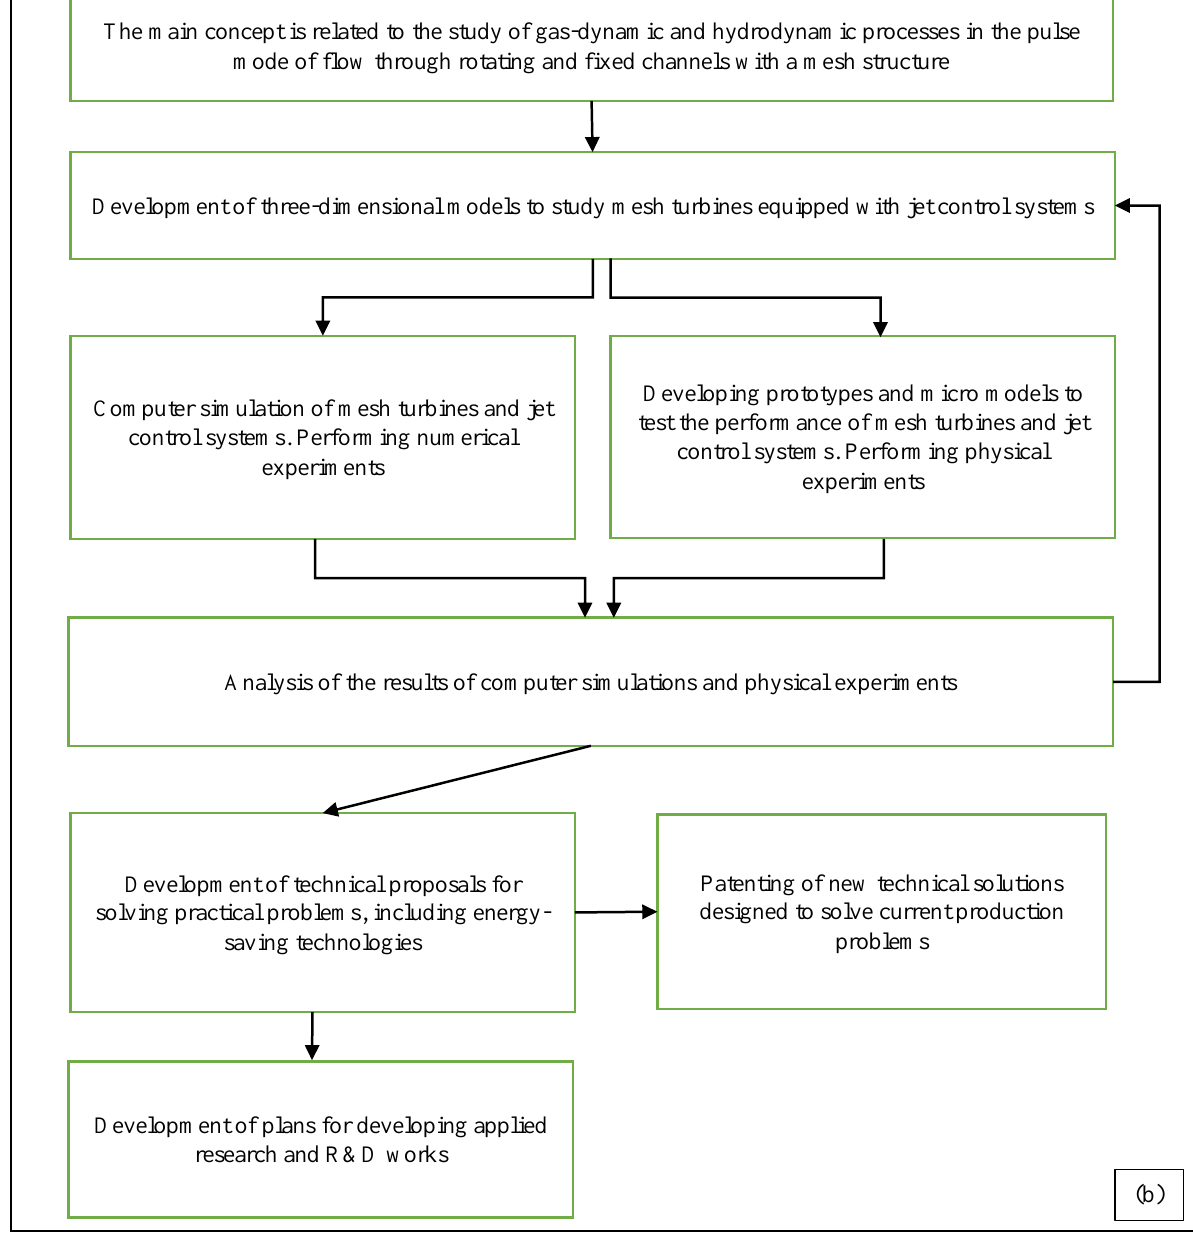
Figure 1. (a) Photo of 3D printers used to develop mesh turbines with jet control systems and (b) flowchart to explain the research